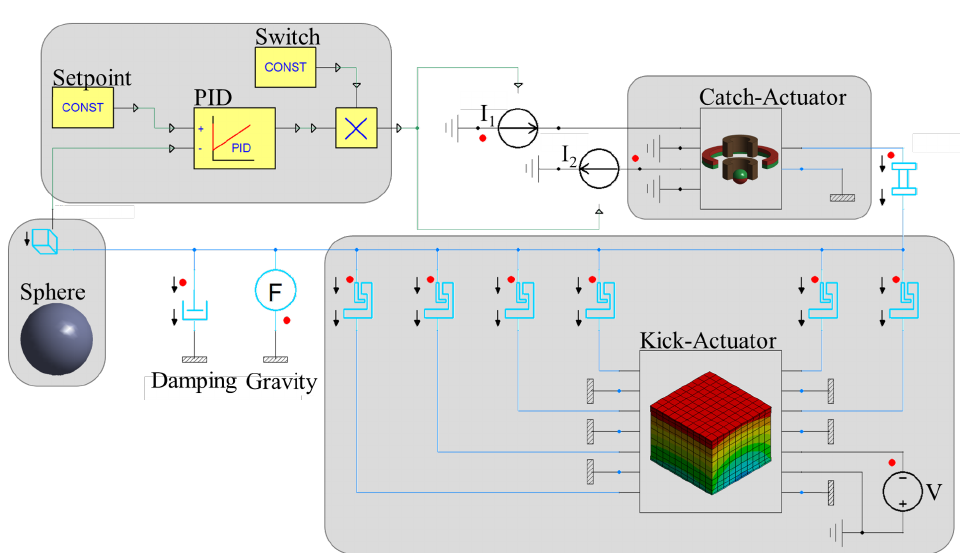
Figure 5. Schematic diagram of the kick and catch actuator system at system-level, extended by a PID-based position control of the sphere. The four grey areas indicate the system’s major components: the controller, the electromagnetic catch-actuator, the piezoelectric kick-actuator, and the sphere (clockwise from top left). The catch-actuator is modelled as an equivalent circuit, the kick-actuator as an ROM and the micromirror as a point